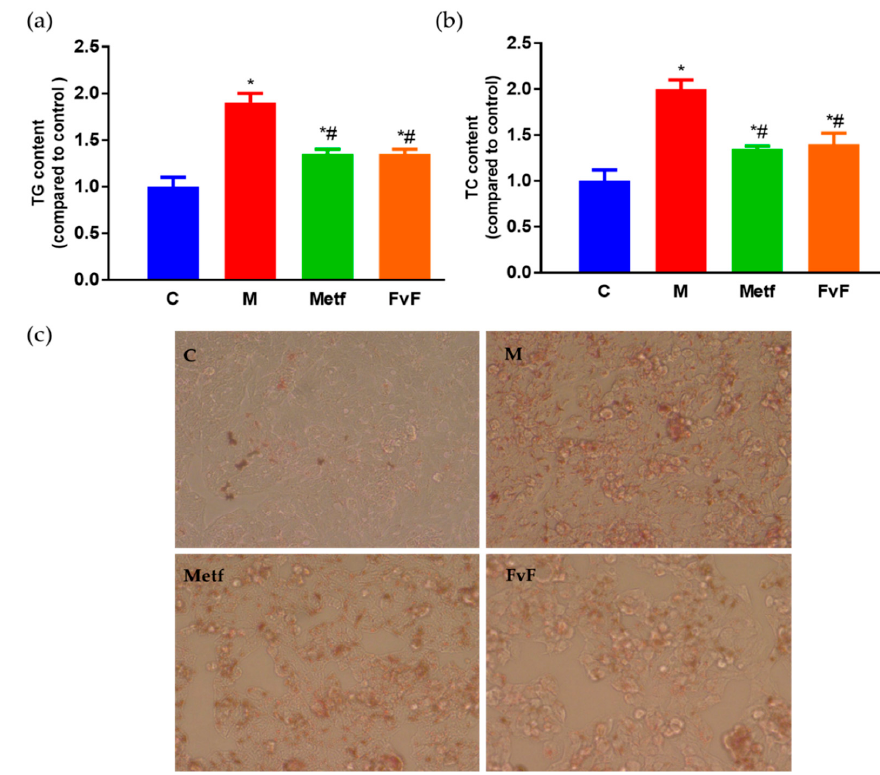
Figure 3. Effects of fucoidan from Fucus vesiculosus (FvF) on lipid metabolism in HepG2 cell. Triglyceride (TG) ( a ) and total cholesterol (TC) ( b ) contents. ( c ). Oil Red O staining of HepG2 cells (100×). C, control group; M, cells treated with 100 μ M PA for 24 h; Metf and FvF, cells treated with 100 μ M PA in the presence of metformin (2 mM) or FvF (100 μ g/mL) for 24 h. Data are expressed as the mean ± SEM. Differences were assessed by ANOVAs and statistical results are denoted as follows: * p < 0.05 versus the control group; # p < 0.05 versus the model group.